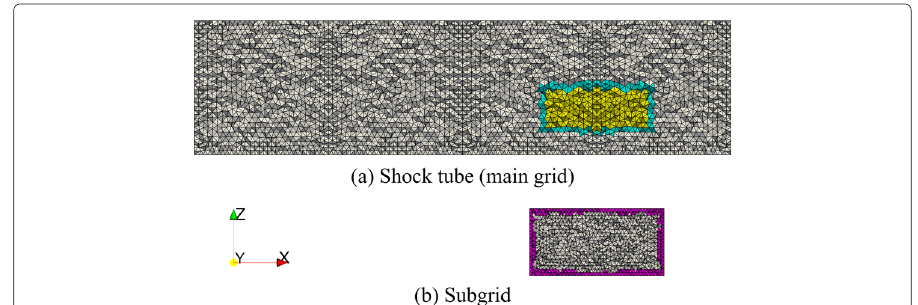
Fig. 6 Computational grids for the shock tube